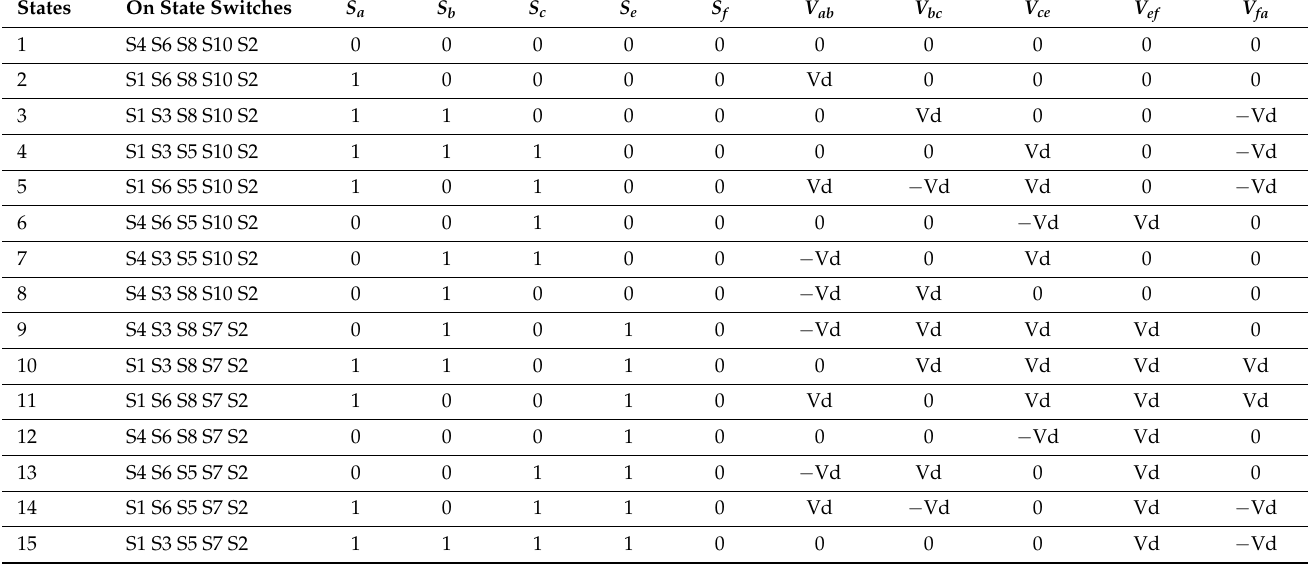
Table 2. Switching states of five-phase inverter for line